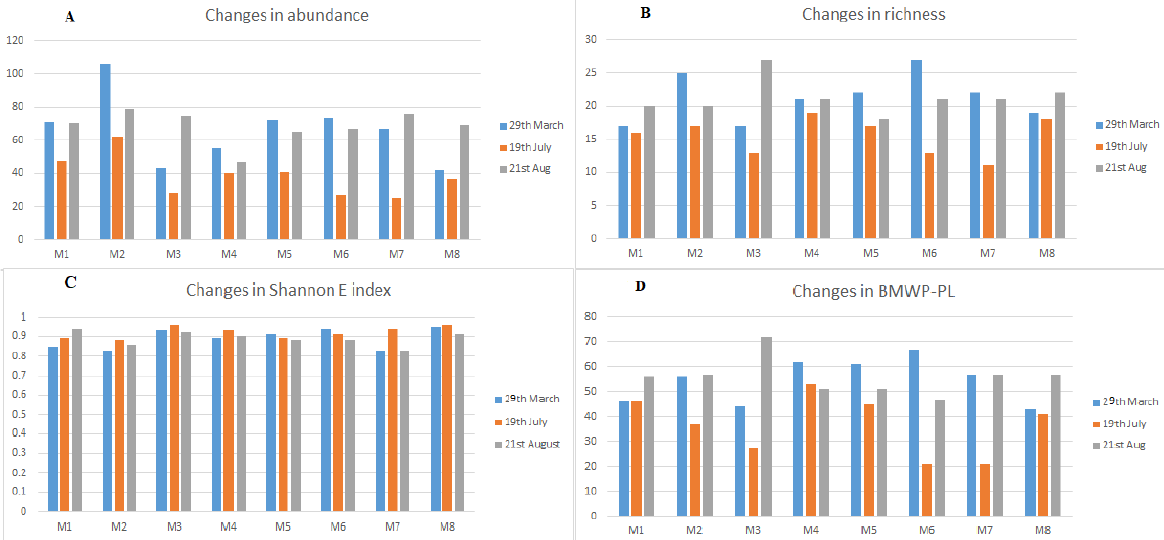
Figure 8. Spatial variation of ( A ) abundance, ( B ) richness, ( C ) Shannon evenness index (E), and ( D ) BMWP-PL for the three sampling dates.